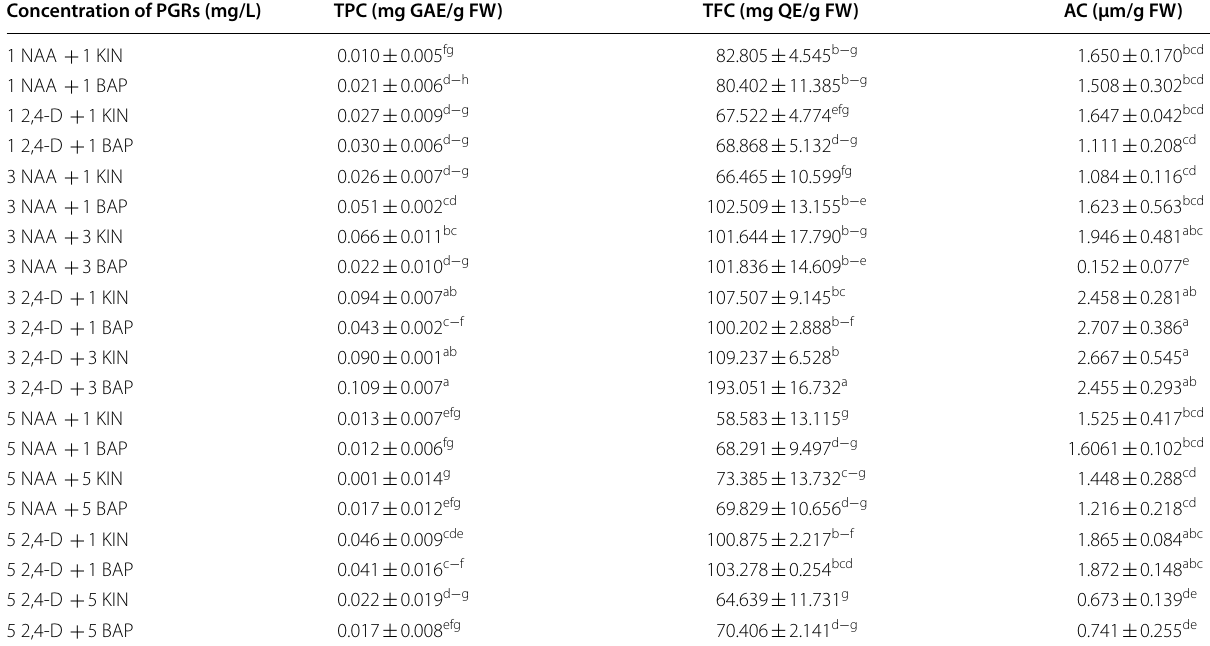
Table 3 The effect of plant growth regulators on total phenolic (TPC), Total flavonoid (TFC), and anthocyanin (AC) content in the callus cultures of M. azedarach L.